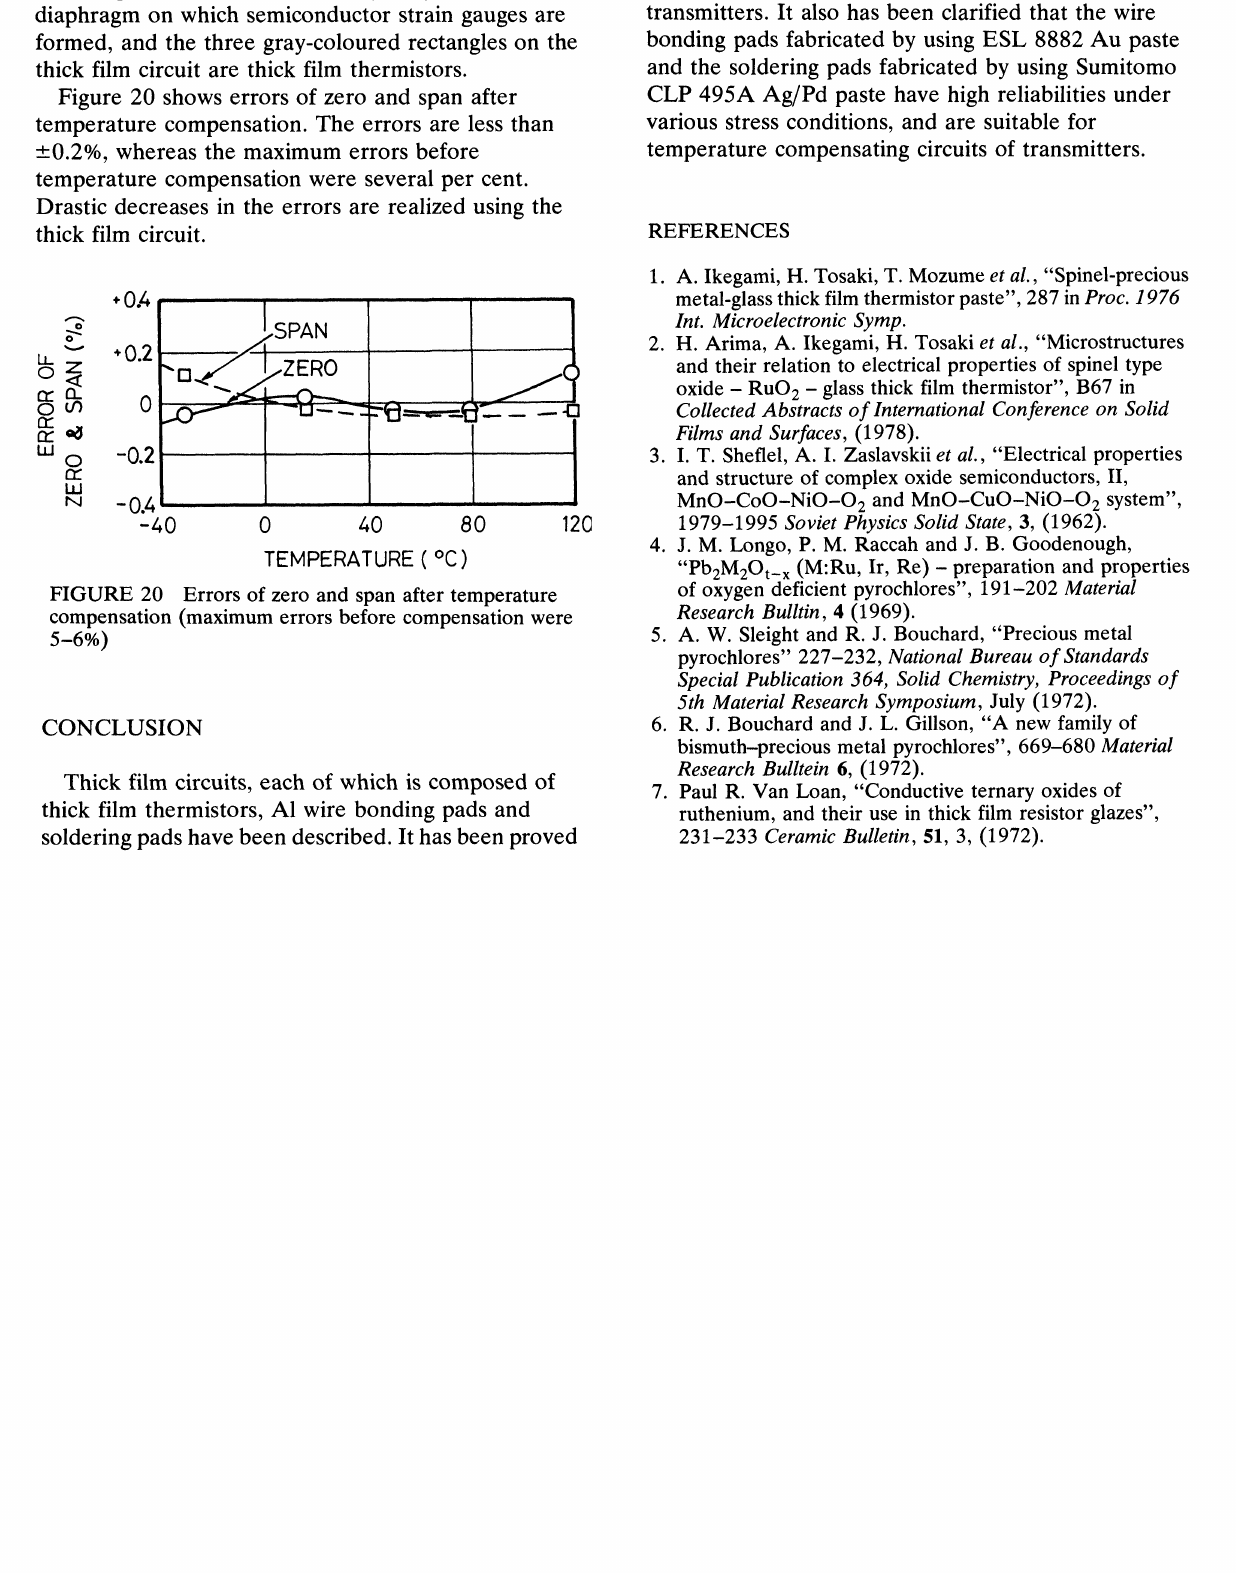
FIGURE 20 Errors of zero and span after temperature compensation (maximum errors before compensation were